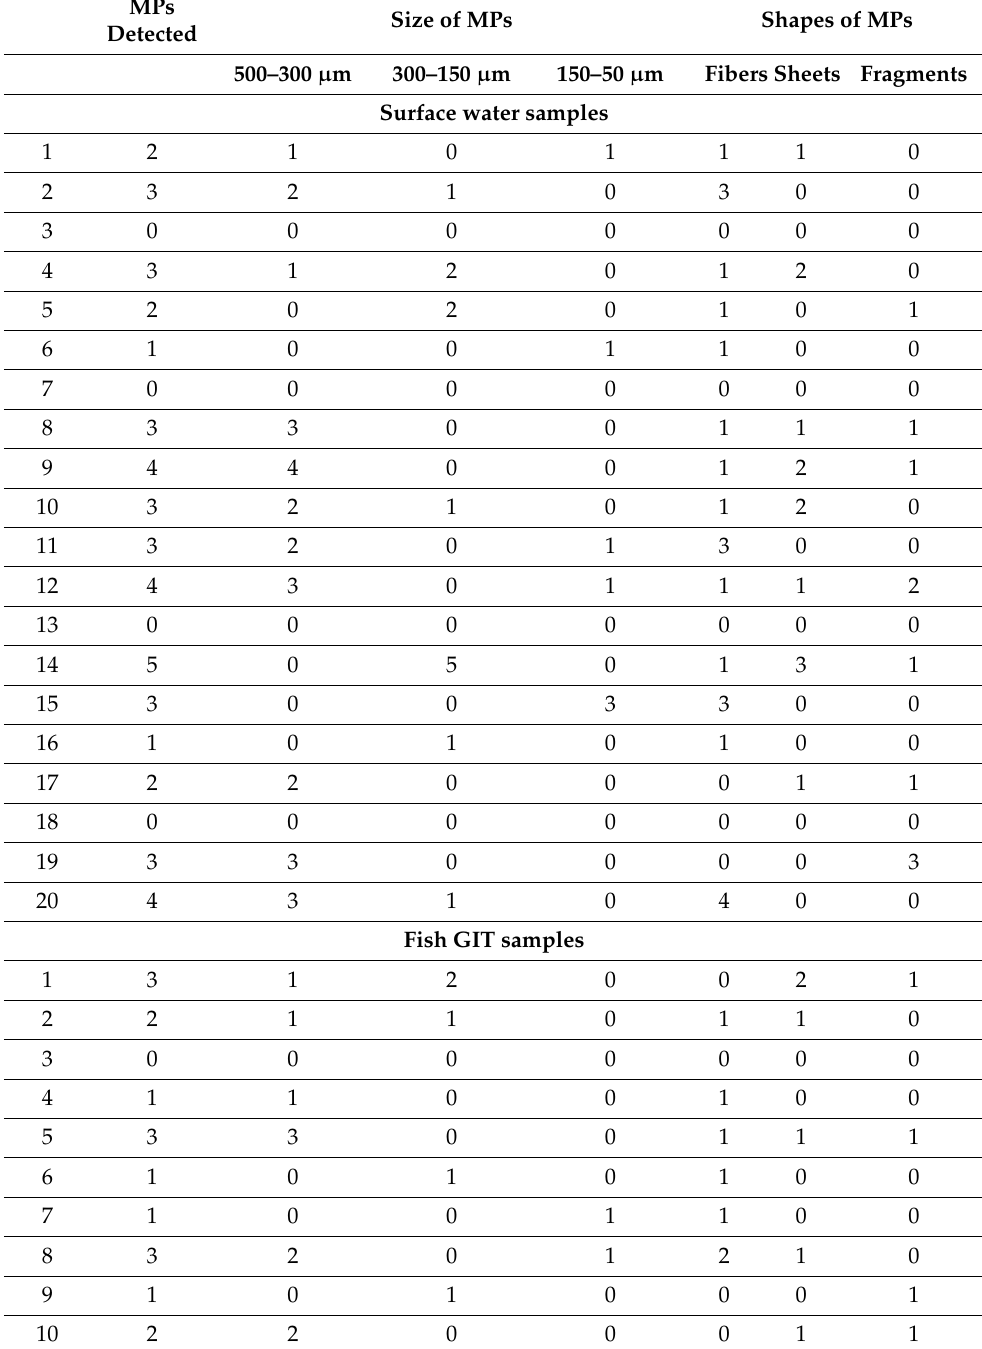
Table 1. Relative abundance of different sizes and shapes of MPs